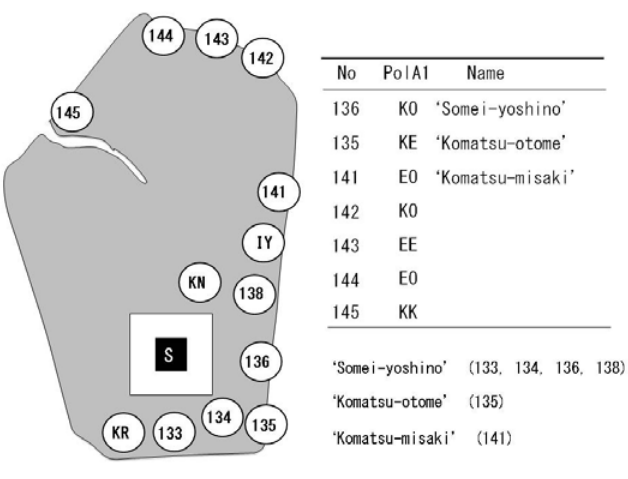
Fig. 6 - Haplotype of the PolA1 intron 19 of trees (Nos. 135-145) found around “Komatsu no miya” statue (S) in the Ueno Park. ‘Somei-yoshino’ (133, 134, 136, 138) and ‘Komatsu-otome’ (135) share a haplotype K, P. pendula (E), P. lannensiana (O). IY, KN and KZ are flowering cherry cultivars, ‘Ichi-yo,’ ‘Kan- zan,’ and ‘Kanzakura,’